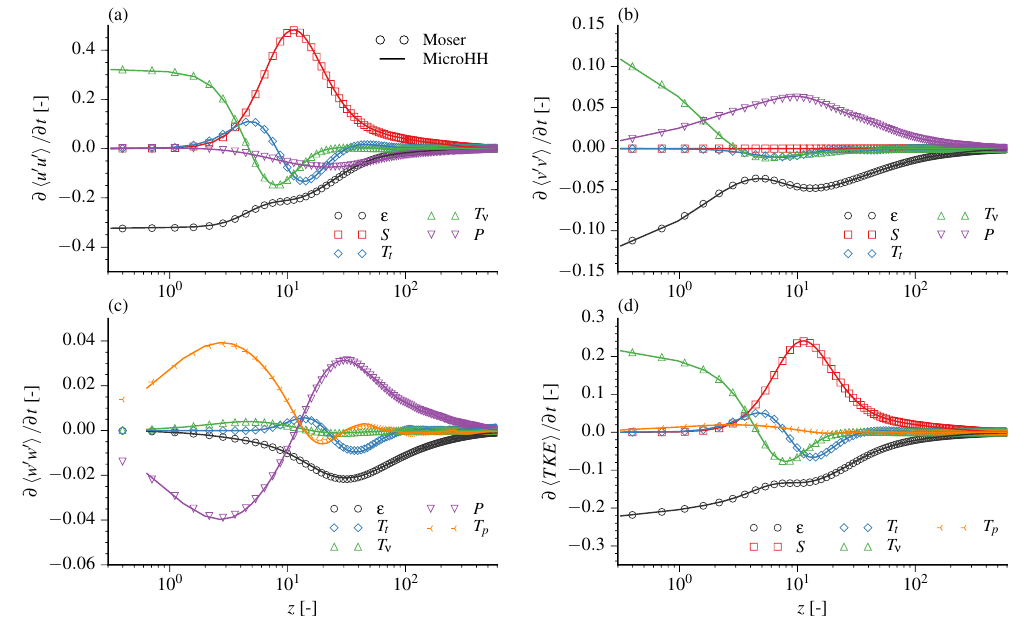
(cid:16) (cid:17) u (cid:48) 2 + v (cid:48) 2 + w (cid:48) 2 / 2) compared against Moser et al. (1999)’s